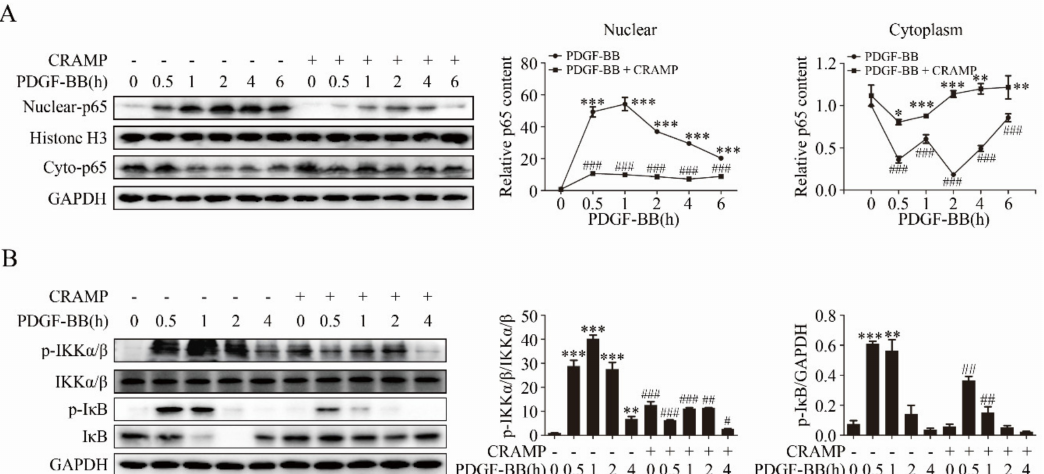
Figure 5. CRAMP regulated IL-6 autocrine via targeting NF- κ B signaling. ( A ) VSMC were pretreated with CRAMP (100 ng / mL) for 2 h and then stimulated with PDGF-BB (20 ng / mL) at di ff erent times (0.5, 1, 2, 4, 6 h). The nuclear- and cyto-p65 were detected by immunoblotting. ( B ) VSMC were pretreated with CRAMP (100 ng / mL) for 2 h and then stimulated with PDGF-BB (20 ng / mL) at di ff erent times (0.5, 1, 2, 4, 6 h). The activation of inhibitor of nuclear factor kappa-B kinase (IKK α / β ) was detected by immunoblotting. Data of 3 independent experiments is presented as mean ± SEM. * p < 0.05, ** p < 0.01, *** p < 0.001 compared with control; # p < 0.05, ## p < 0.01, ### p < 0.001 compared with PDGF-BB treatment group, n =